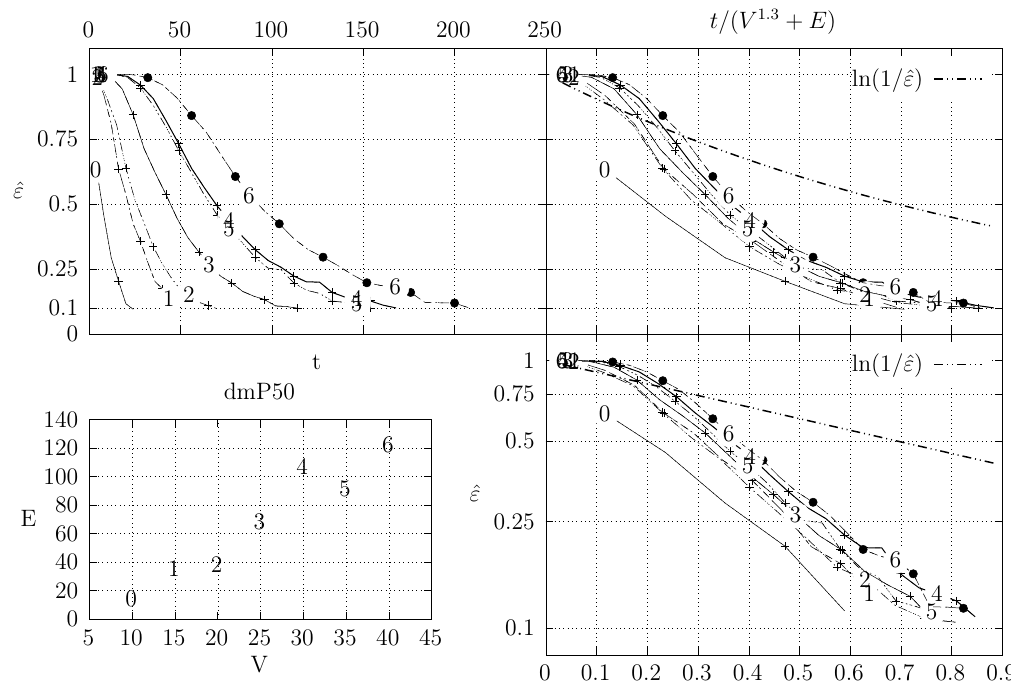
Figure 24. Estimation of variation distance as a function of the number of iterations for dmP graphs (see Section 4.3.1 for details).